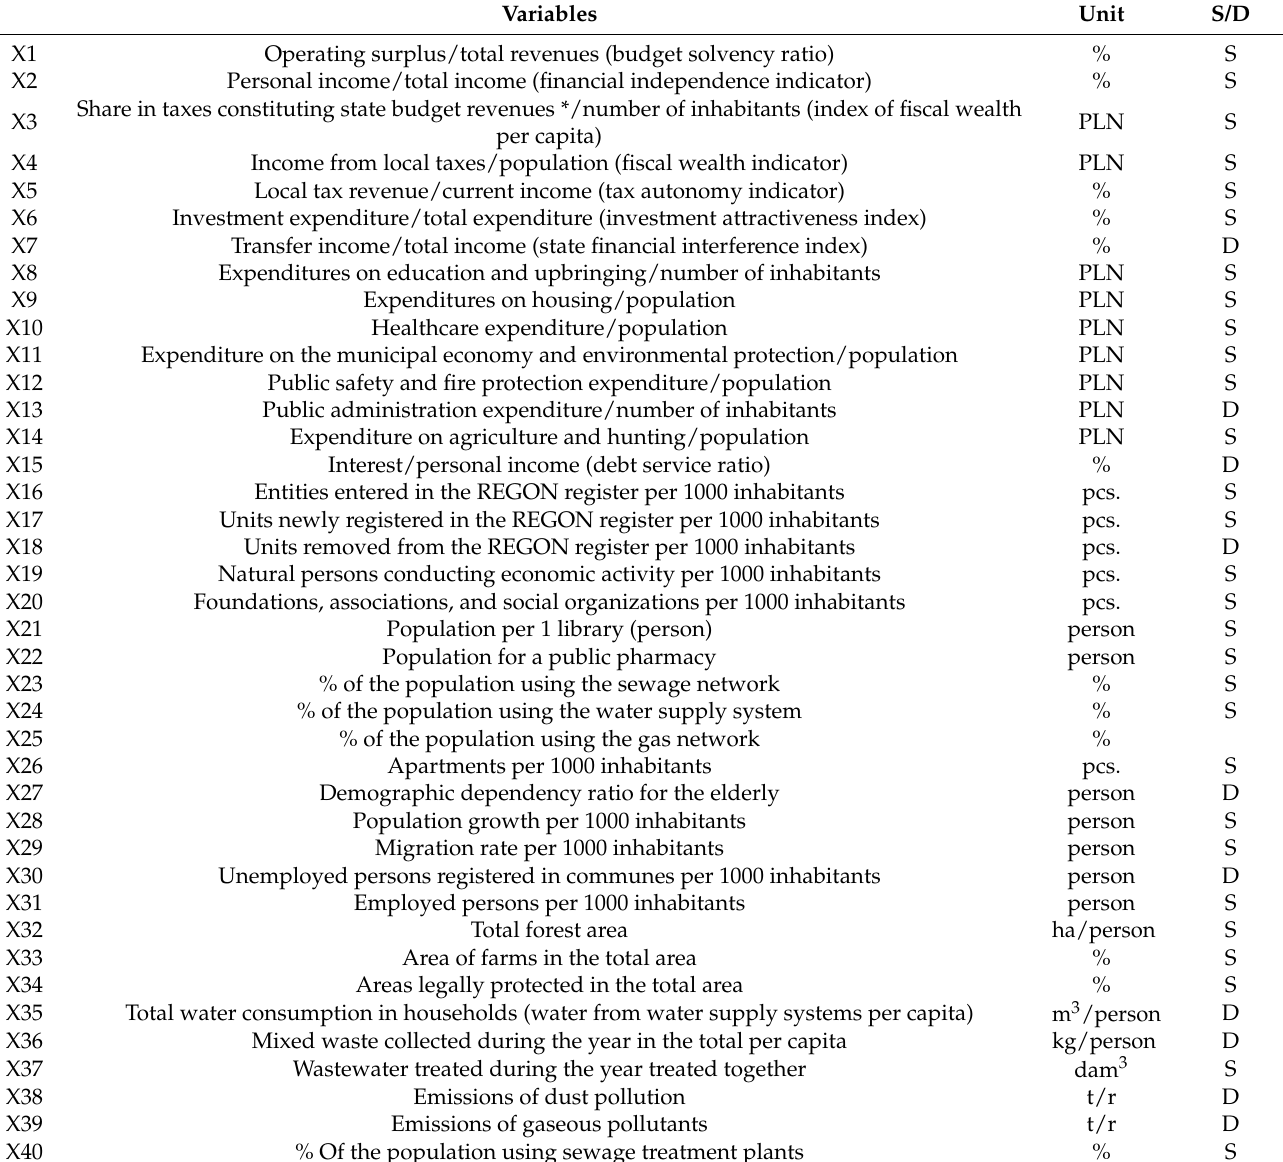
Table 1. List of variables describing the financial situation and economic and social development of communes.